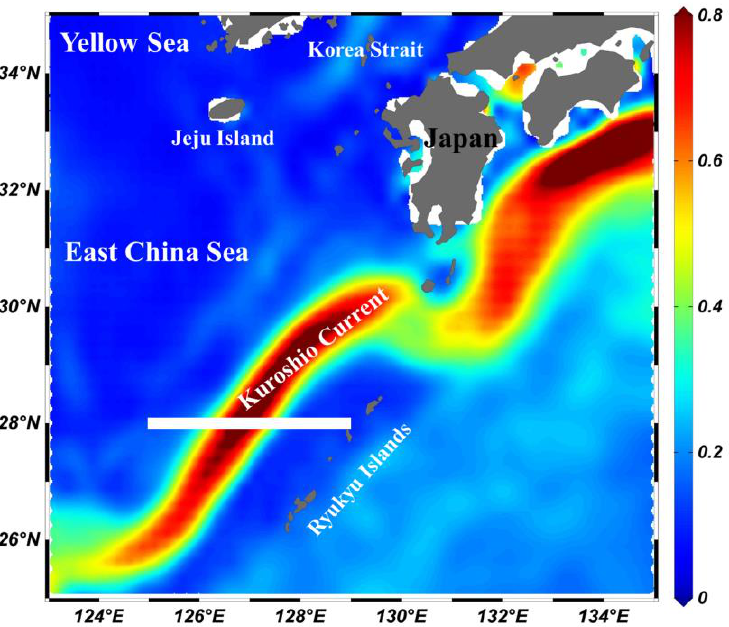
Figure 2. Mean geostrophic sea surface current velocity (m/s) from satellite in January during 1993–2021. The white bar indicates the area where the intensity and longitudinal shift of Kuroshio Current was studied.